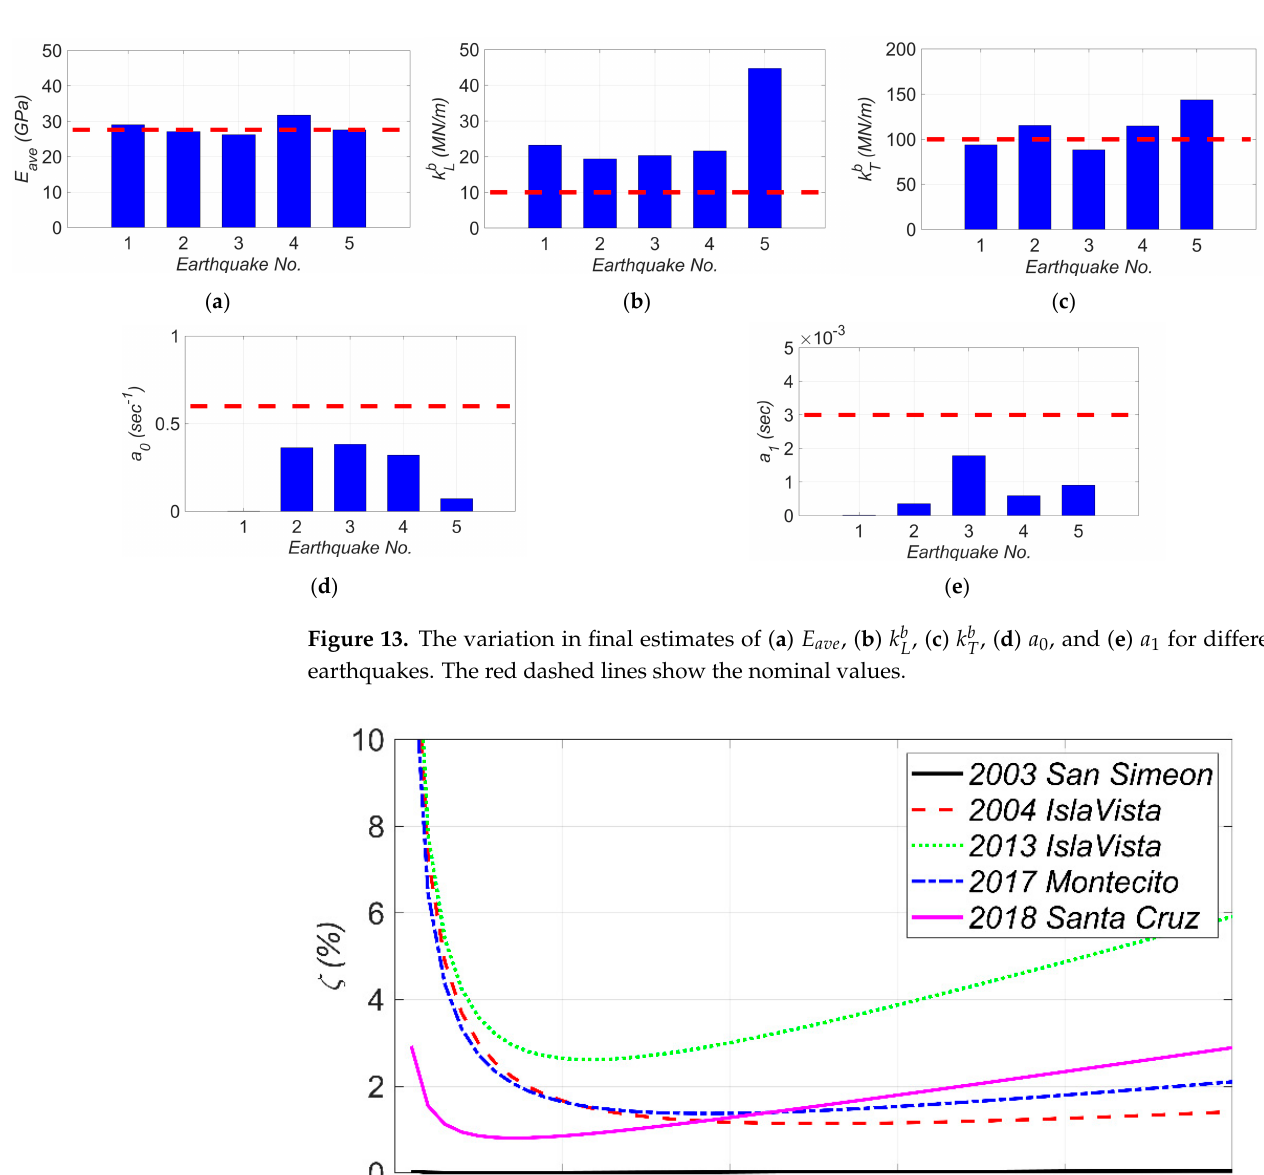
, ( b ) (cid:1863) (cid:3013)(cid:3029) , ( c ) (cid:1863) (cid:3021)(cid:3029) , ( d ) (cid:1853) (cid:3028)(cid:3049)(cid:3032)